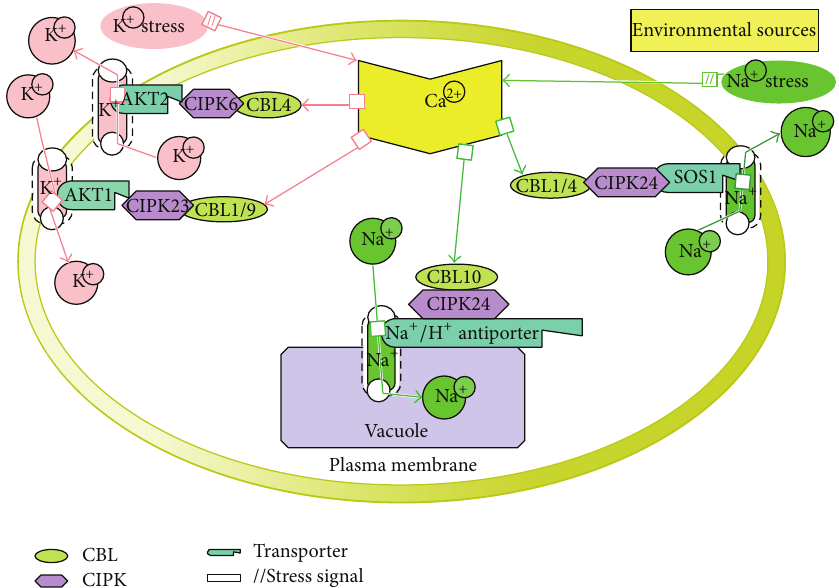
Figure 1: This model represents the identified CBLs-CIPKs interactions process and how they respond to abiotic stresses from environmental sources and maintain homeostasis in cell. All signals are centrally controlled by Ca 2+ . Different colors indicate different pathways. AKT1: Arabidopsis K + transporter 1, AKT2: Arabidopsis K + transporter 2, and SOS1: salt overly sensitive 1. Mechanism in short: environmental stresses trigger Ca 2+ ; Ca 2+ transmits signal to sensor molecule Calcineurin B-like (CBL) protein-CBL-interacting protein kinase (CIPK) to activate the transporters to create ion homeostasis in cell.